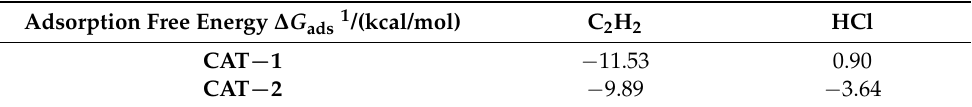
Table 1. The adsorption Gibbs free energy ( ∆ G ads ) of HCl and C 2 H 2 adsorbed on catalyst CAT − 1 and CAT − 2